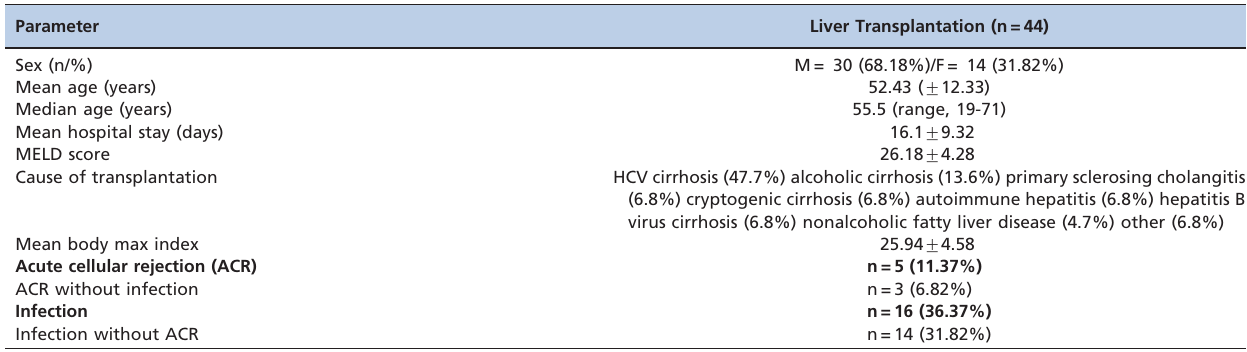
Table 1 - Demographic parameters for all liver transplantation patients.